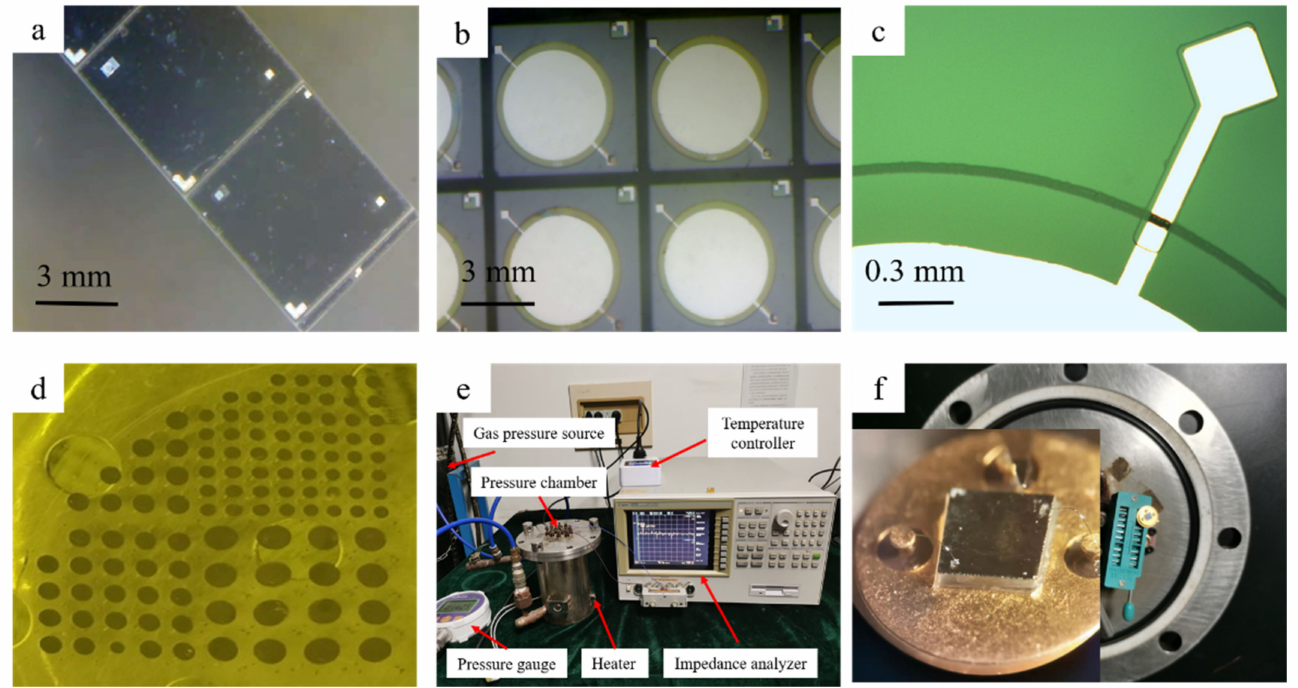
Figure 5. Photos of ( a ) the fabricated devices and the partial structures of ( b ) lower electrode, ( c ) feedthrough line and ( d ) insulating layer in the glass cavities; Photos of ( e ) the measurement system and ( f ) the mounting location of sensor and the device packaged in TO39